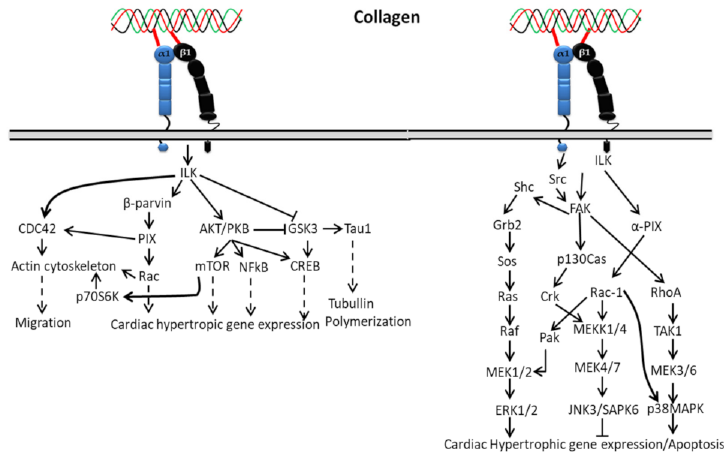
Figure 2. Collagen integrin signals in cardiac hypertrophic gene